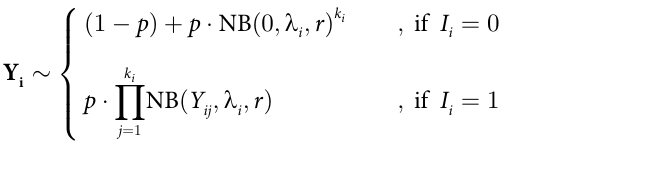
which corresponds to a zero-inflated negative binomial model with p corresponding to the mixing proportion. NB is the negative binomial distribution and I